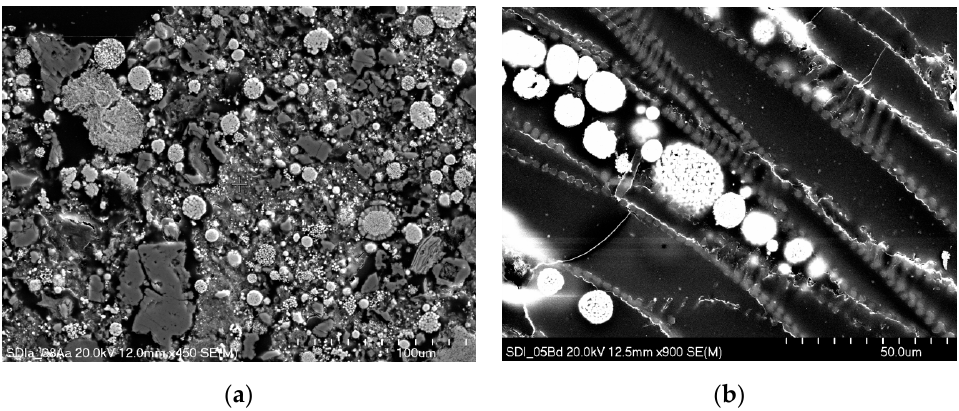
Figure 9. SEM picture (samples from profiles BPI and BPII) of framboidal pyrites loosely dispersed in matrix of quartz, dolomite and organic material ( a ) and organized in elongated structures filling remnants of plant tissues ( b ).